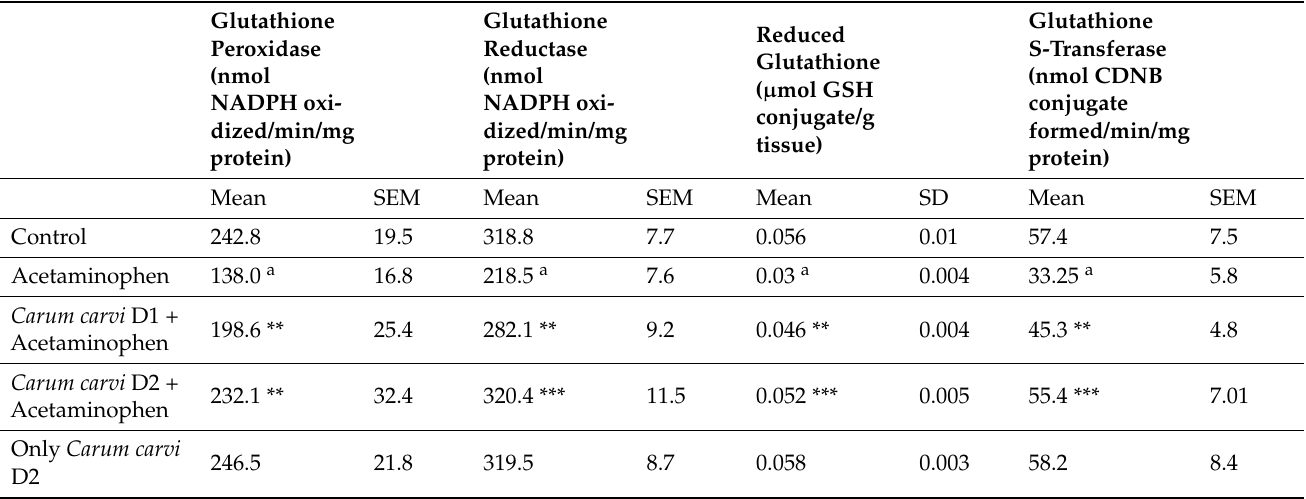
Table 3. Effect of Carum carvi on the acetaminophen-induced alterations in glutathione content and dependent